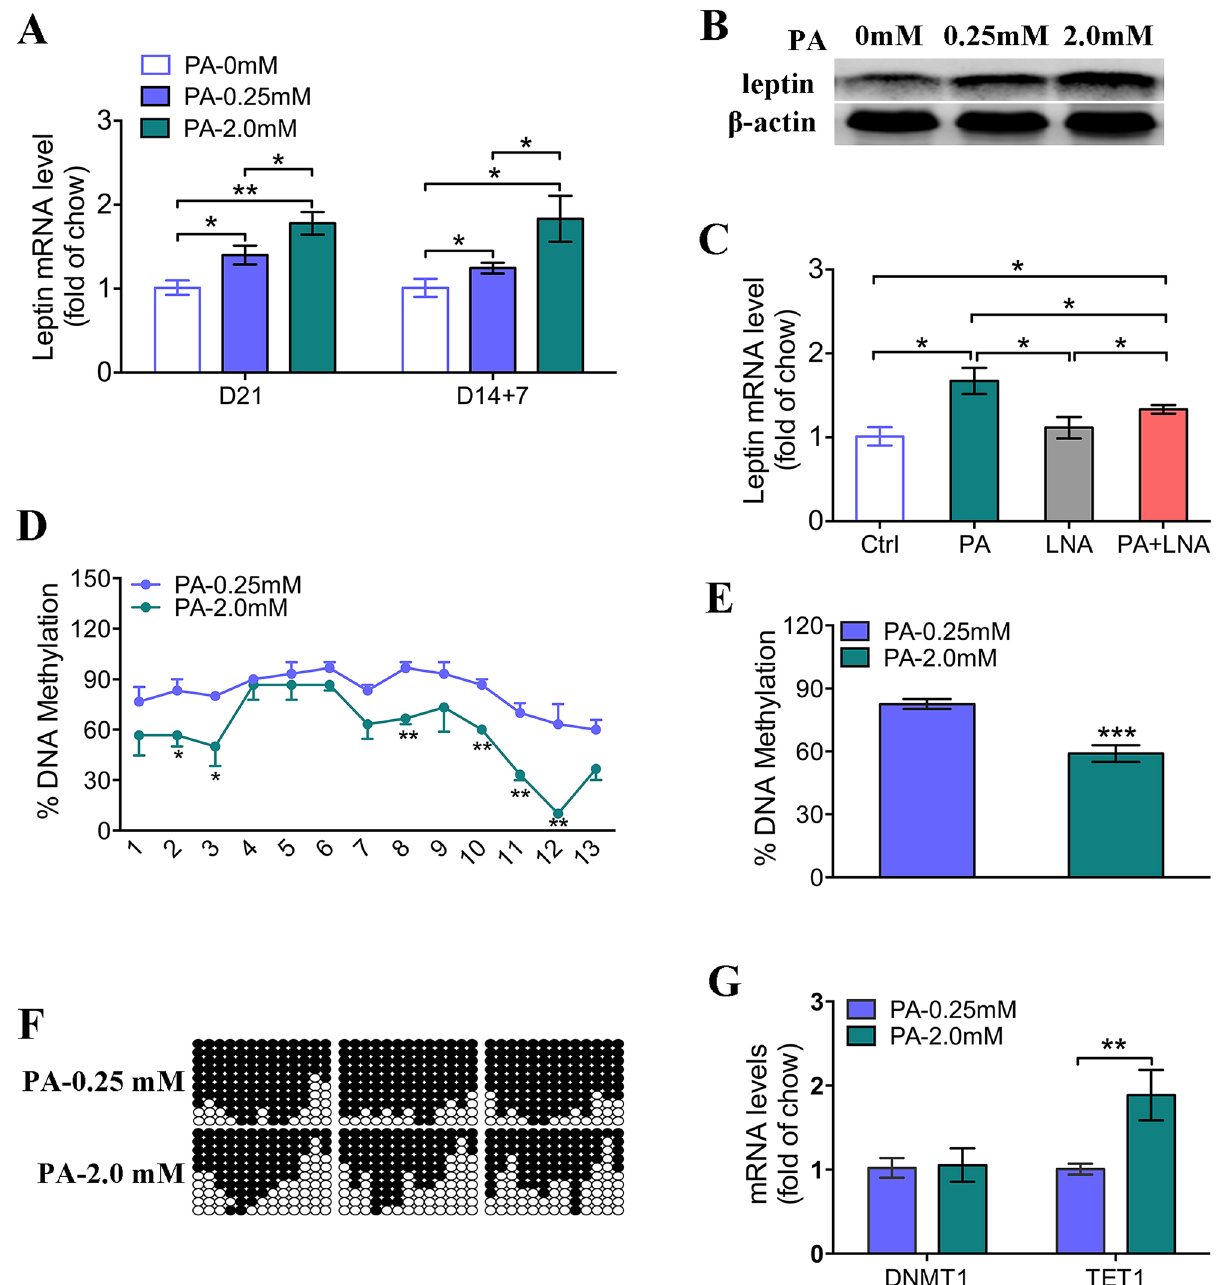
Figure 4. High levels of fatty acids reprogram leptin levels in rat mesenchymal stem cells (MSCs) during adipogenesis. ( A ) Leptin mRNA levels were measured following the treatment of MSCs for 21 days with vehicle or palmitic acid (PA; 0.25 or 2 mM; n = 4 for each group) or treatment with PA for 14 days followed by vehicle treatment for 7 days (D14 + 7). ( B ) Leptin protein levels were measured following the treatment of MSCs for 21 days with vehicle or PA. The grouping of gels cropped from different parts of the same gel. ( C ) Leptin mRNA levels were measured following the treatment of MSCs with vehicle, PA (1 mM) or PA (1 mM) plus linoleic acid (LNA; 1 mM) for 21 days. ( D ) Methylation levels of individual CpG sites within the leptin promoter in MSCs treated for 21 days with 0.25 or 2 mM PA (n = 3 for each group). ( E ) The overall methylation of the leptin promoter in MSCs treated for 21 days with 0.25 or 2 mM PA (n = 3 for each group). ( F ) The methylation profile of the leptin promoter in MSCs treated for 21 days with 0.25 or 2 mM PA (n = 3 for each group). ( G ) DNMT1 and TET1 mRNA levels were measured following the treatment of MSCs for 21 days with 0.25 or 2 mM PA (n = 4 for each group). Values are expressed as means ± SEs, *** p < 0.0001, ** p < 0.01, * p < 0.05, compared to the corresponding